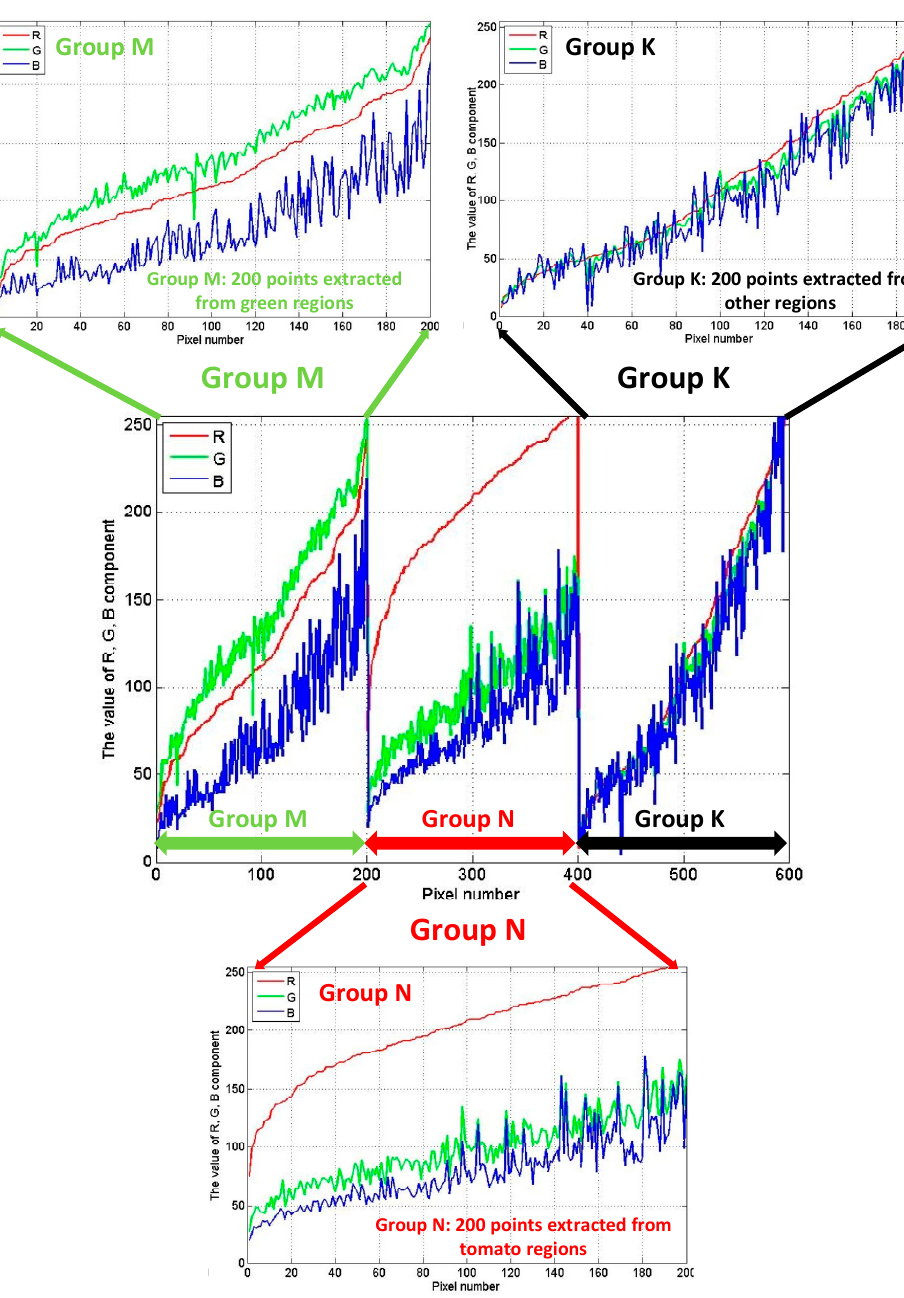
Figure 3. The R, G, B components of three groups M, N and K.